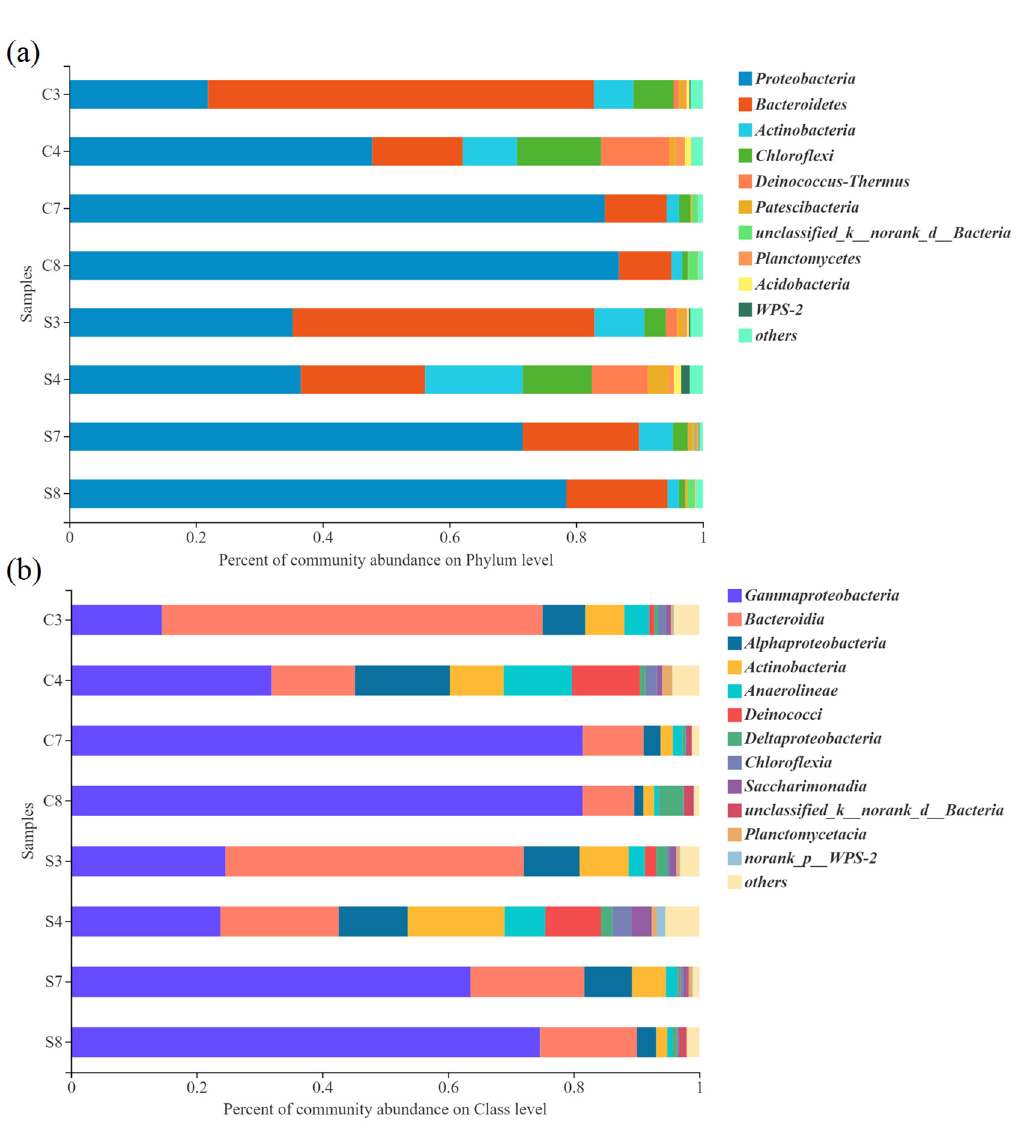
Figure 4. Microbial community structures of the eight samples at the phylum level ( a ) and class level ( b